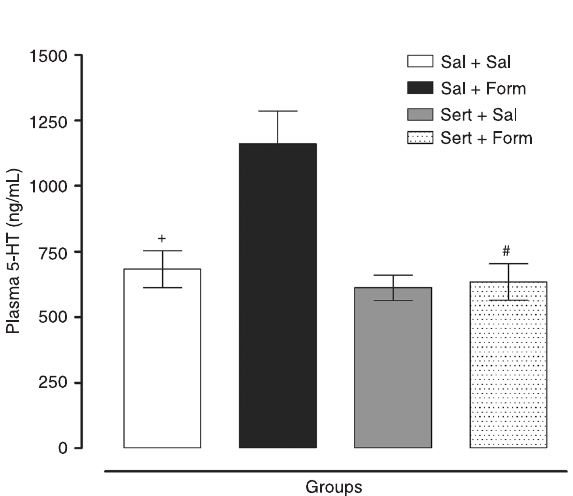
Figure 2. Plasma levels of serotonin (5-HT) 50 min after formalin or saline injection into the rat paw. Data are reported as means ± SEM for N = 8 rats per group. Sal = saline; Form = formalin; Ser = sertraline. + P < 0.05, Sal + Form vs Sal + Sal; # P < 0.01, Sal + Form vs Sert + Form group (one-way